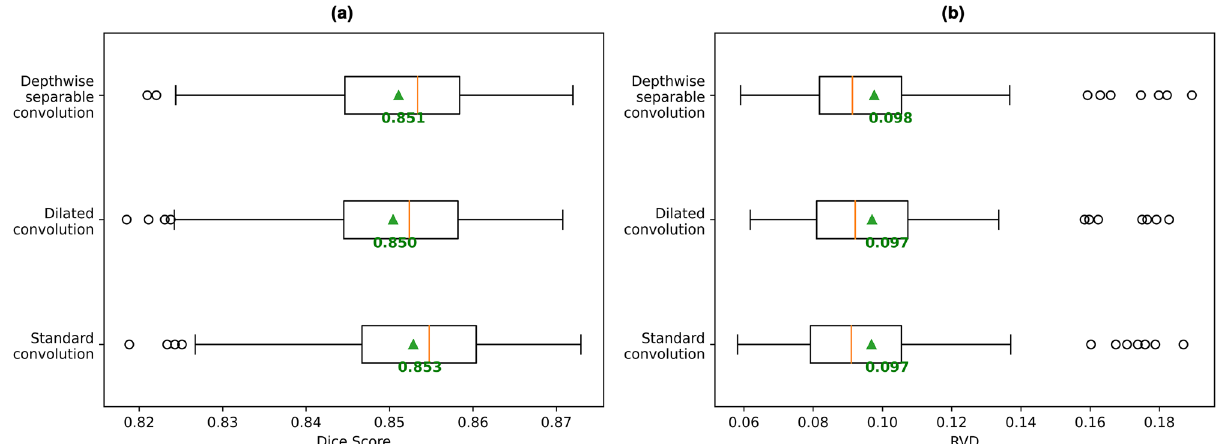
Figure 6. Box plots of performance of UNet3+ models with different convolution operations. All convolution operations in the network were replaced by the specified convolution operations. Box plots of ( a ) the mean Dice scores for all subjects (higher is better), and (b) the mean RVD values for all subjects (lower is better). Mean across all subject scores is indicated by green arrow and text. Orange bar indicates median